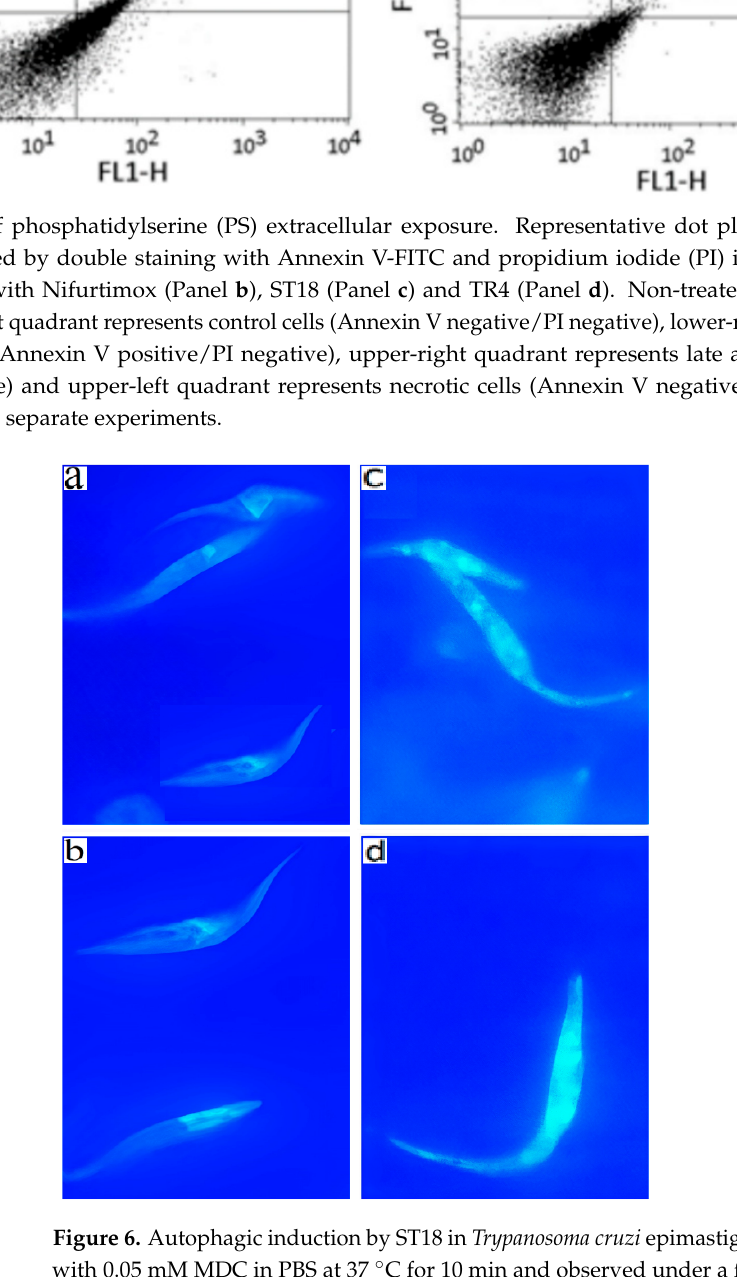
Nikon Eclipse E 200 (100×). ( a and b ): Control. ( c and d ): T. cruzi epimastigotes treated for 72 h with